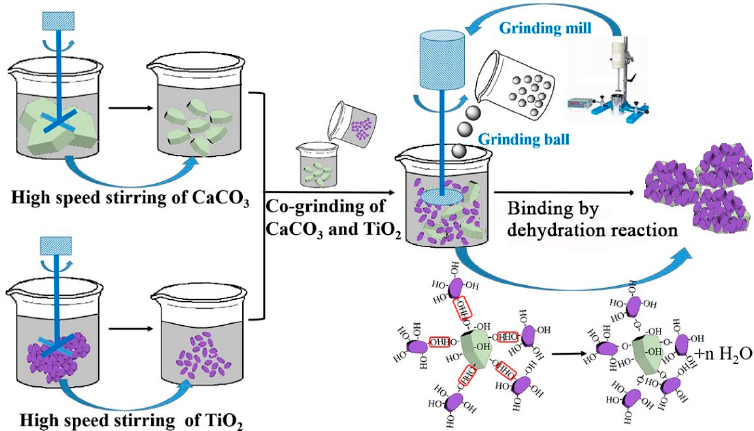
Figure 4. Preparation mechanism of CaCO 3 -TiO 2 composite particles.